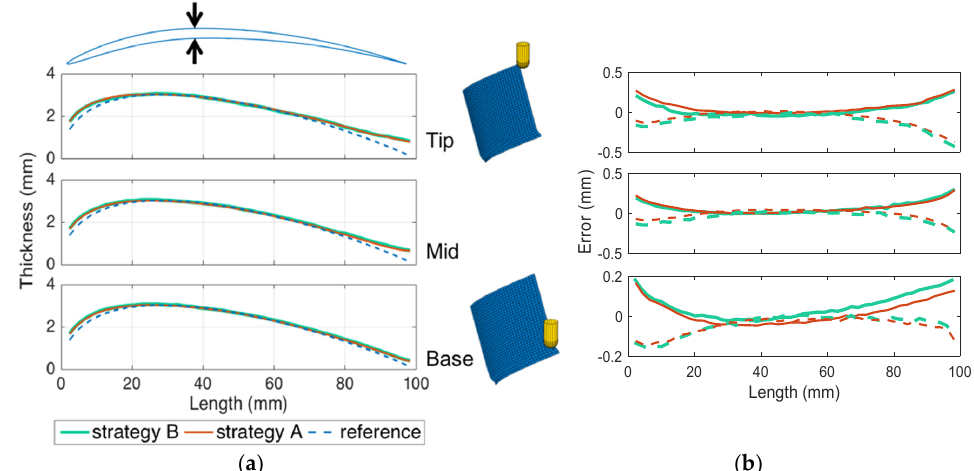
Figure 13. Camber line at different Z-level ( a ) camber line ( b ) camber line error.